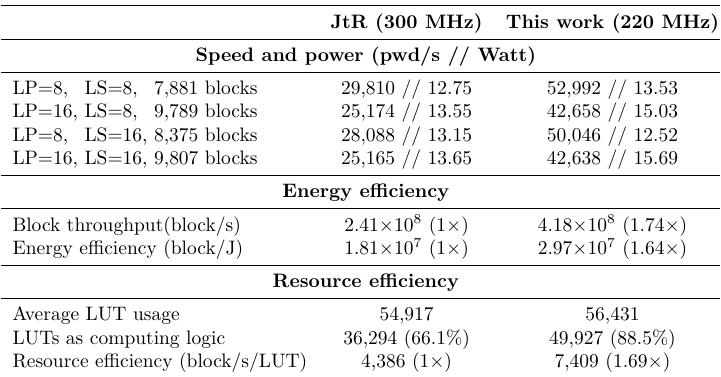
Table 7: Comparison with